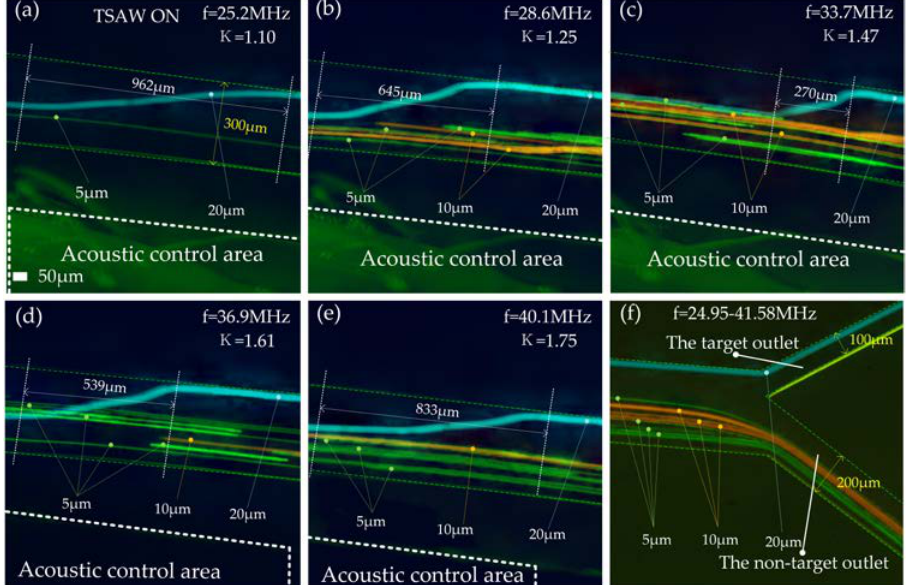
Figure 8. The test effect diagram after superimposing the particle tracks of each particle size: ( a ) Track test diagram of particles in the acoustic control region when f = 25.2 MHz; ( b ) Track test diagram of particles in the acoustic control region when f = 28.6 MHz; ( c ) Track test diagram of particles in the acoustic control region when f = 33.7 MHz; ( d ) Track test diagram of particles in the acoustic control region when f = 36.9 MHz; ( e ) Track test diagram of particles in the acoustic control region when f = 40.1 MHz; ( f ) Track test diagram of particles at the outlet of the flow channel when f = 24.92–41.58 MHz.